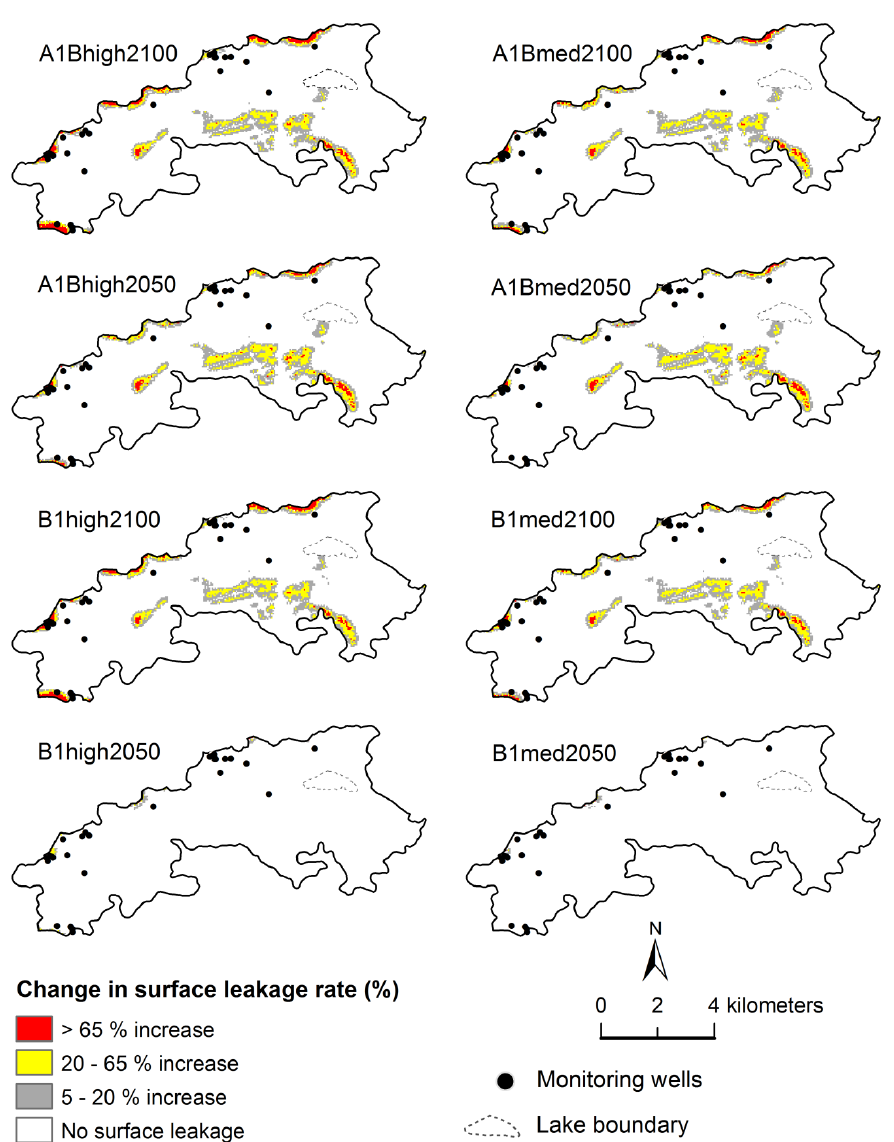
Figure 12. Spatial distribution of changes in surface leakage rate (%) in climate scenarios A1B and B1 and their high and medium (med) sea level scenarios for the periods 2021–2050 and 2071–2100 compared with present